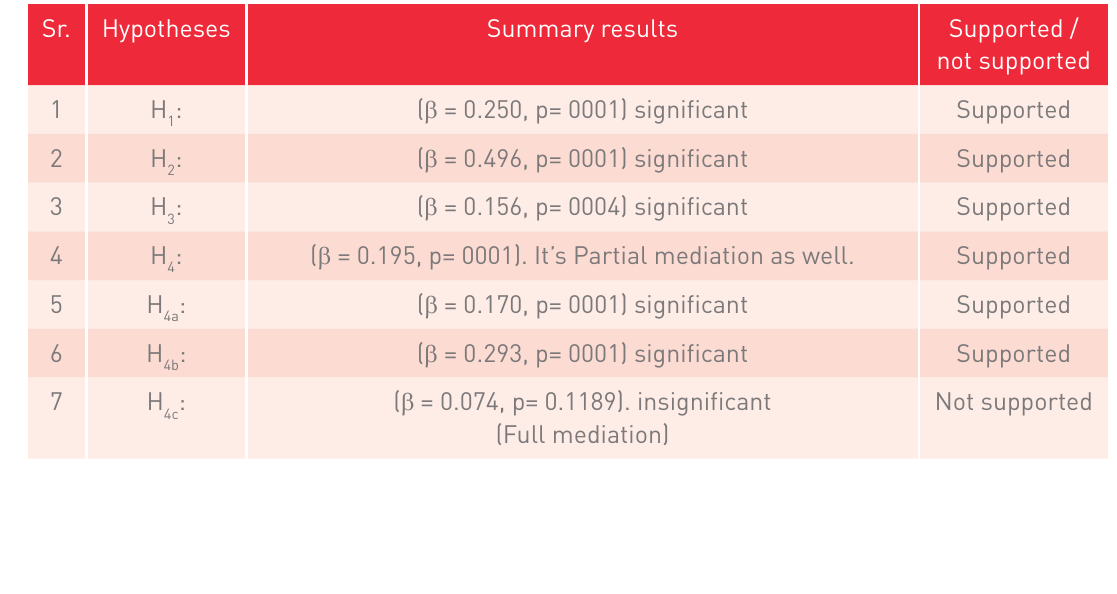
Hypotheses results